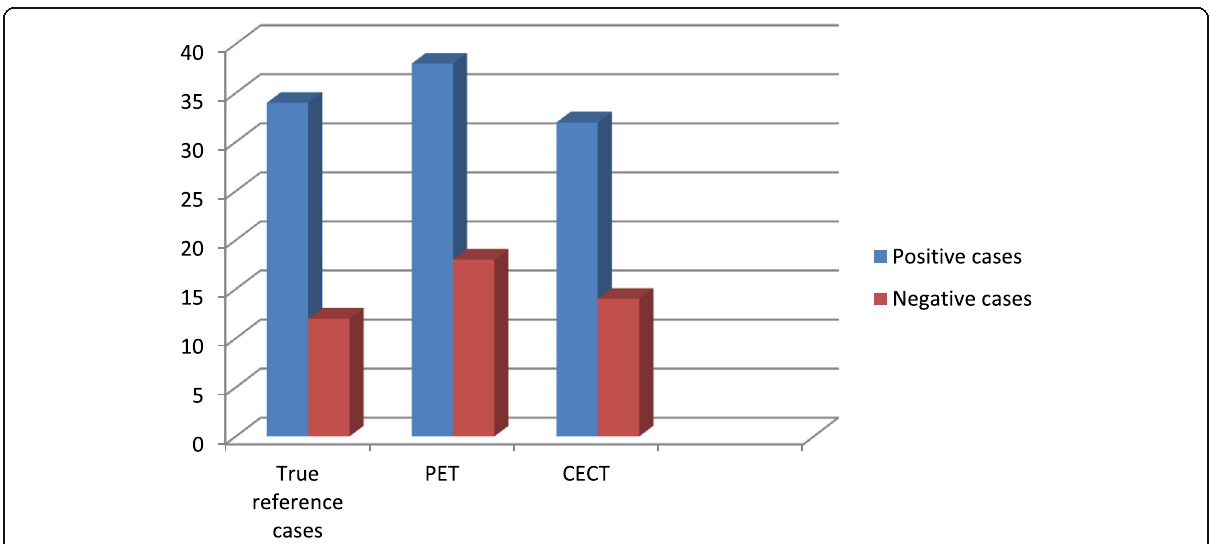
Fig. 1 Chart of correlation between positive and negative results in true, PET, and CECT